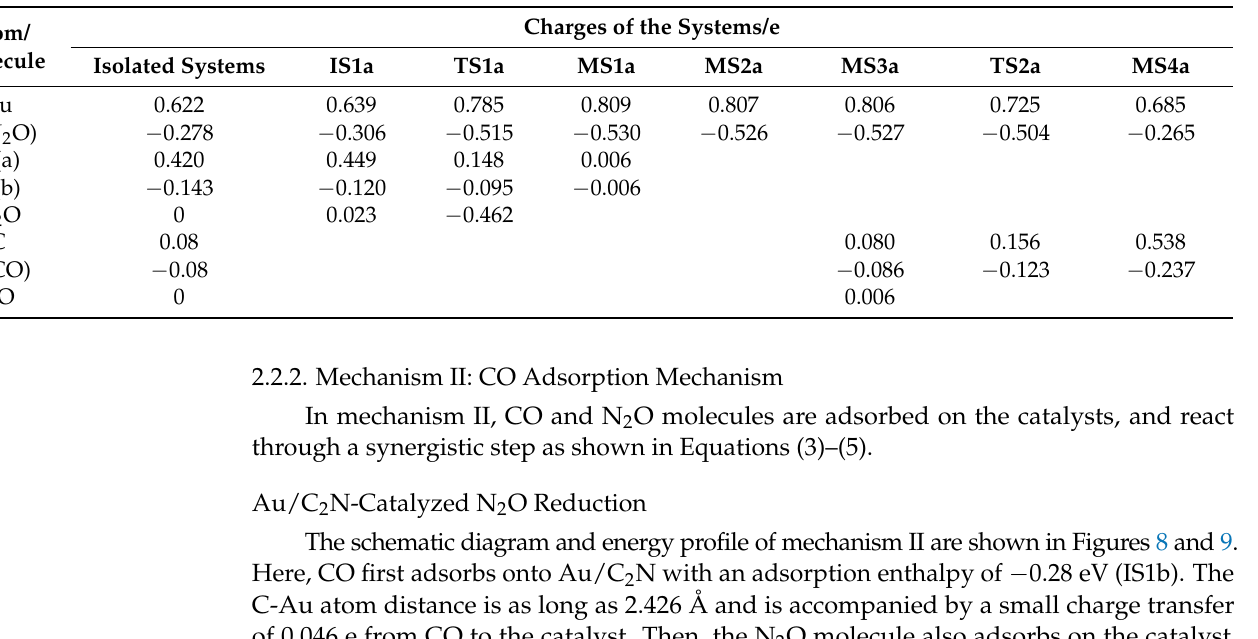
Table 3. The Mulliken charge of species involved in Cu/C 2 N catalytic reduction of N 2 O reaction mechanism I. (Note that N(a) represents the N atom bonding with N and O atoms, and N(b) represents the ending N atom).